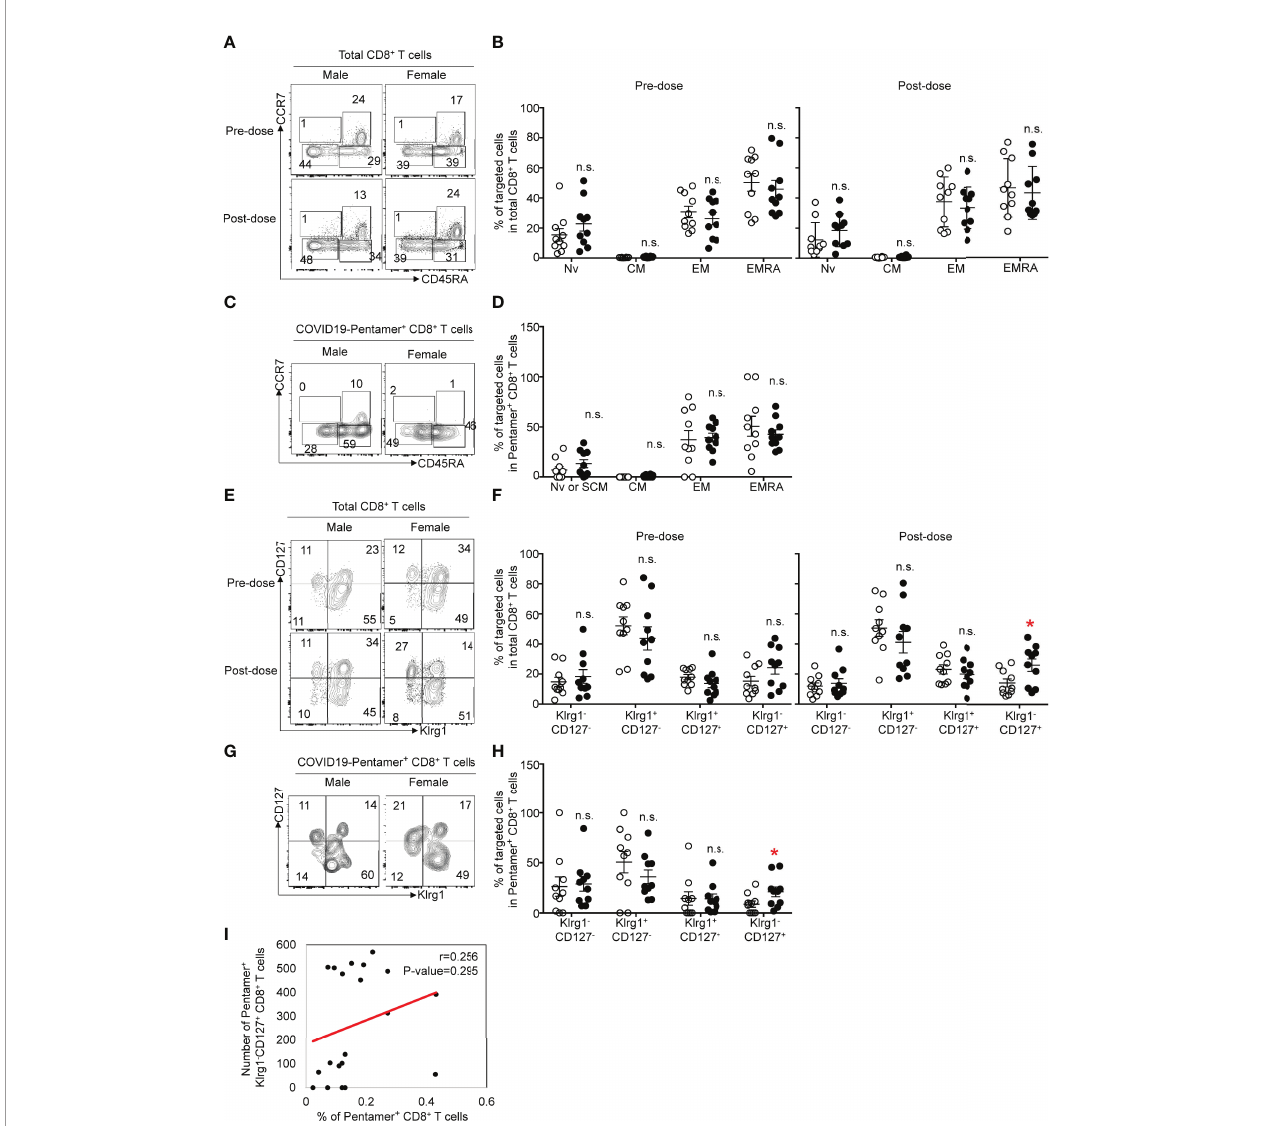
FIGURE 3 | (A) Flow cytometric analysis of CD3 + CD8 + CCR7 + CD45RA + (naïve: Nv), CCR7 + CD45RA - (central memory: CM), CCR7 - CD45RA - (effector memory: EM) and CCR7 - CD45RA + (terminal effector memory: EMRA) T cells among CD8+ T cells from male or female before or after vaccination. Dot plots of CD45RA and CCR7 expression in PI - CD3 + CD8 + PMBCs are shown. (B) Frequency of Nv, CM, EM and EMRA CD8 + T cells among PMBCs from males or females before or after vaccination. (C) Flow cytometric analysis of CD3 + CD8 + COVID-19-pentamer + Nv, CM, EM and EMRA T cells among PMBCs from males or females after vaccination. Dot plots of CD45RA and CCR7 expression in PI - CD3 + CD8 + COVID-19-pentamer + PMBCs are shown. (D) Frequency of Nv, CM, EM and EMRA COVID-19-pentamer + CD8 + T cells among PMBCs from males or females after vaccination. (E) Flow cytometric analysis of CD3 + CD8 + KLRG1 - CD127 - , KLRG1 + CD127 - , KLRG1 + CD127 + and KLRG1 - CD127 + T cells among PMBCs from males or females before or after vaccination. Dot plots of KLRG1 and CD127 expression in PI - CD3 + CD8 + PMBCs are shown. (F) Frequency of KLRG1 - CD127 - , KLRG1 + CD127 - , KLRG1 + CD127 + , and KLRG1 - CD127 + CD8 + T cells among PMBCs from males or females before or after vaccination. (G) Flow cytometric analysis of CD3 + CD8 + COVID-19-pentamer + KLRG1 - CD127 - , KLRG1 + CD127 - , KLRG1 + CD127 + and KLRG1 - CD127 + T cells among PMBCs from males or females after vaccination. Dot plots of KLRG1 and CD127 expression in PI - CD3 + CD8 + PMBCs are shown. (H) Frequency of KLRG1 - CD127 - , KLRG1 + CD127 - , KLRG1 + CD127 + , and KLRG1 - CD127 + COVID-19-pentamer + CD8 + T cells among PMBCs from males or females after vaccination. (I) Scatter plots of the number of pentamer + KLRG1 - CD127 + CD8 + T cells and the percentage of COVID-19-pentamer + CD8 + T cells after vaccination. *p < 0.05; n.s., not signi fi